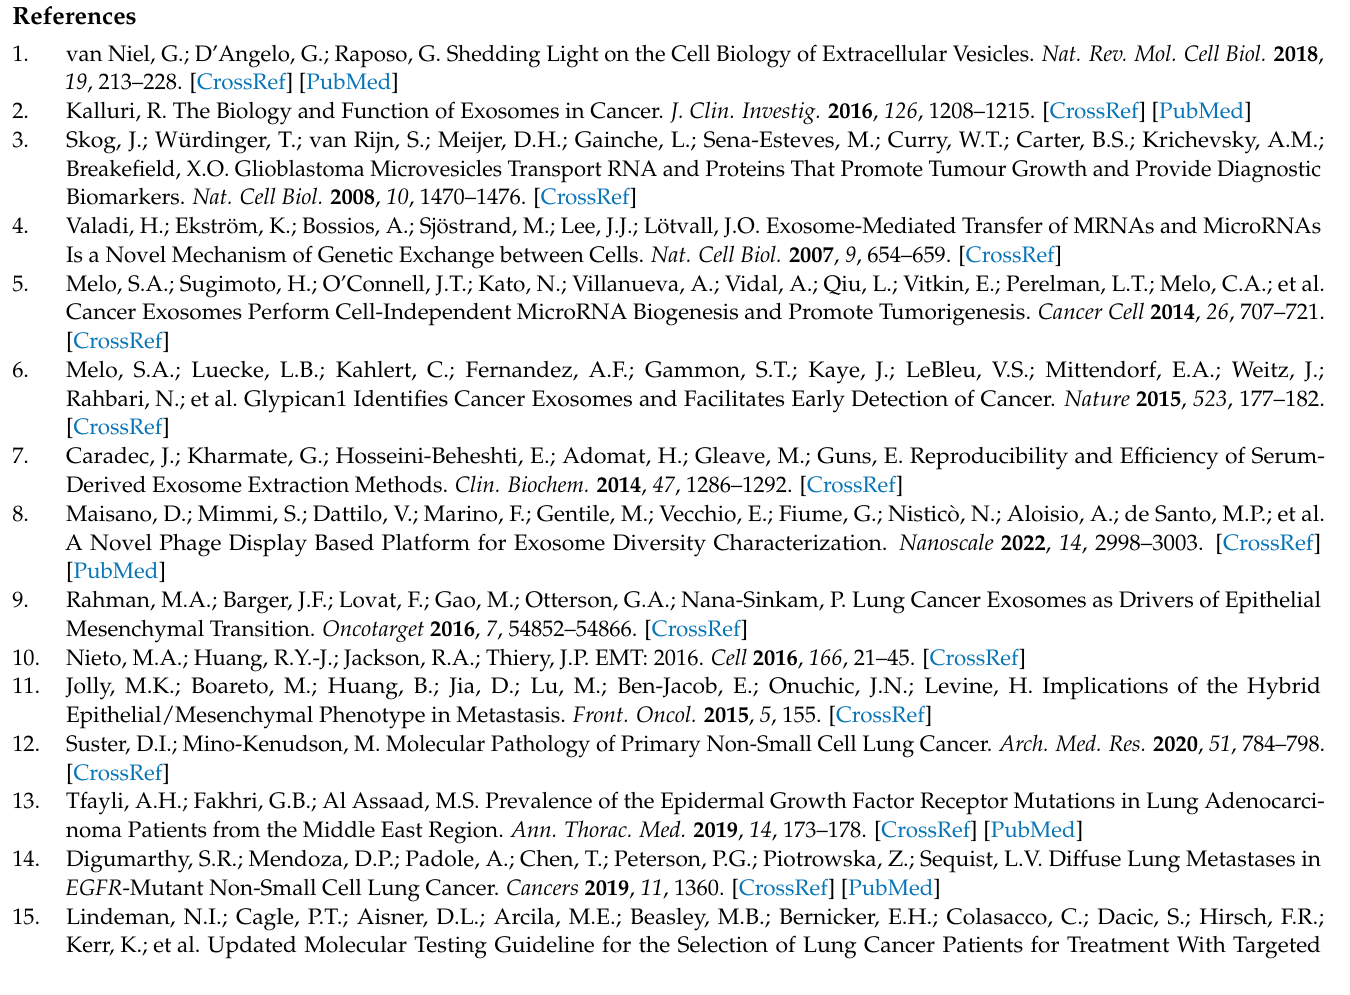
Images for Figure 1C. Figure S2 Original whole Western-blot Images for Figure 2C. Figure S3: Original whole Western-blot Images for Figure 4B. Figure S4: Exosomes derived from HCC827 cell line promote extracellular matrix degradation and EMT; Figure S5: Original whole Western-blot Images for Figure S4. Figure S6: Exosomes from HCC827 cell line don’t alter tight junction expression. Table S1: Patient characteristics. Table S2: Densitometry reading for Figure 1C. Table S3: Densitometry reading for Figure 2C. Table S4: Densitometry reading for Figure 4B. Table S5: Densitometry reading for Figure S4. Video S1: Exosomes from HCC827 cell line increase wound